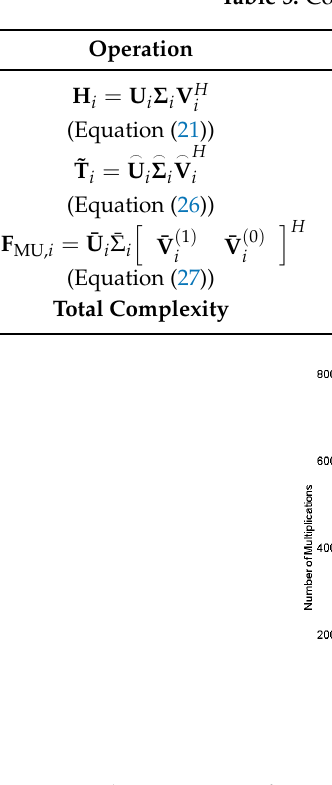
Figure 9. The comparison for computational complexity when each of 3 UEs has 3 receive antennas and BS has 9 transmit